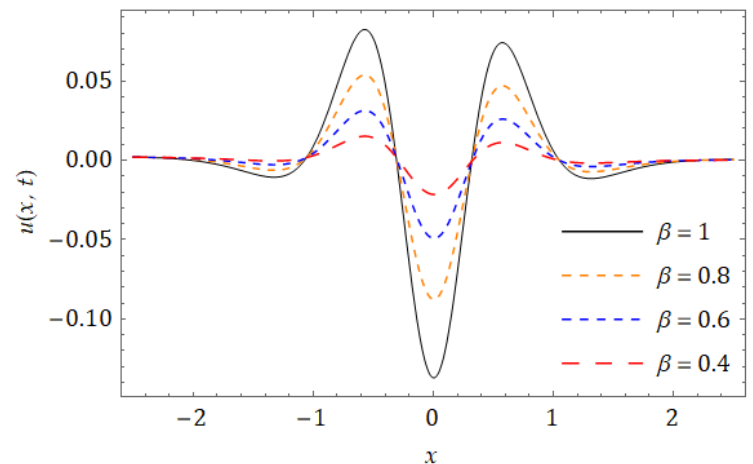
Figure 7. Response of the obtained solution with distinct 𝛽 and time at 𝑛 = 1, 𝑡 = 0.5, ℏ = −1, 𝛼 = 1, κ 1 = κ 2 = 1 and ρ = 0.001 for Case II.